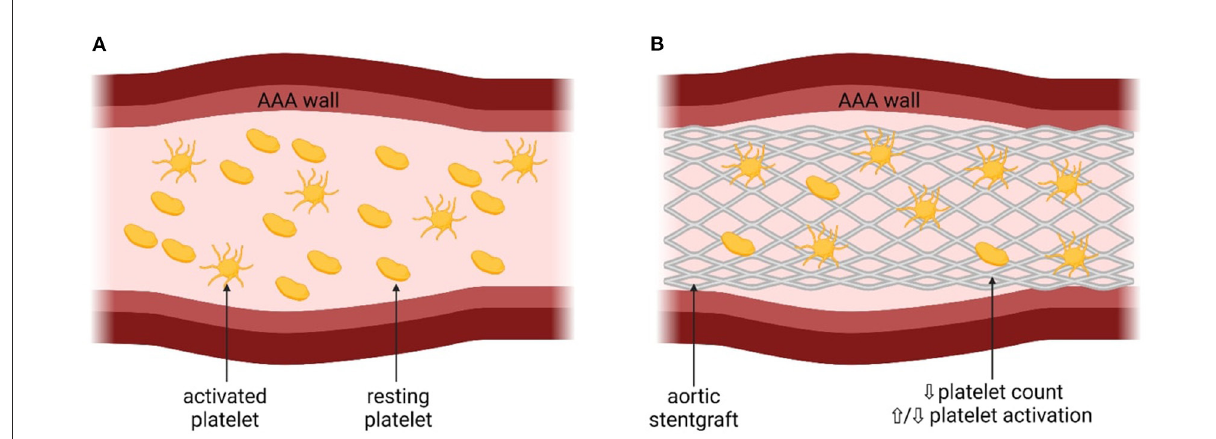
FIGURE1 The mechanism of platelet activation associated with abdominal aortic aneurysm. AAA, abdominal aortic aneurysm; eoxPL, enzymatically oxidized phospholipids; sP, selectin – surface P-selectin; PF4, platelet factor 4; aIIb β 3, platelet integrin aIIb β 3; CD40L, CD40 ligand. (A) Platelets before the insertion of the stentgraft, with the presence of AAA. (B) Platelets after the insetion of the